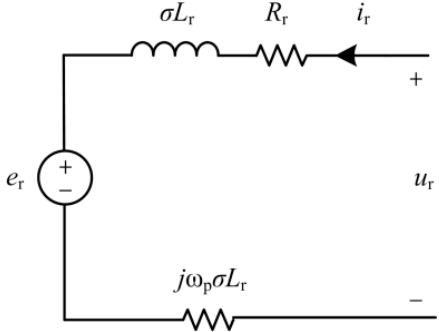
Figure 2. Rotor equivalent circuit of the DFIG.